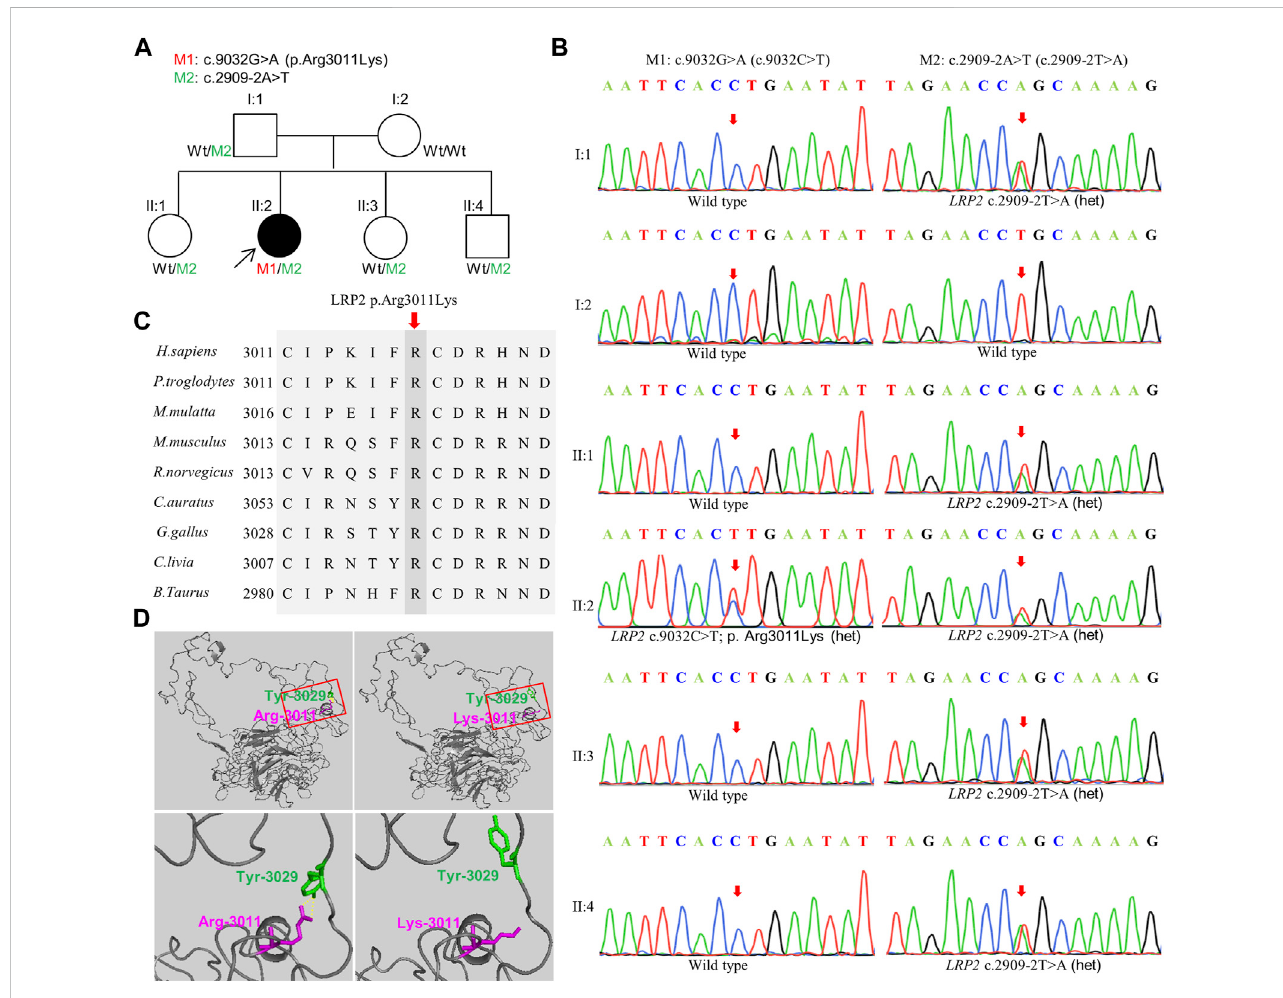
FIGURE 2 Validation of the variation. (A) Pedigree information. Filled black symbol represents the affected member. Two variations are M1: c.9032G > A (p.Arg3011Lys) and M2: c.2909-2A > T, Wt indicates Wild type. Proband is indicated by arrow. (B) Complementary sequence chromatograms of identi fi ed sites for all family members. (C) Orthologous protein sequence alignment of LRP2 from human (H. sapiens), chimpanzees (P. troglodytes), rhesus macaque (M.mulatta), mouse (M. musculus), rats (R. norvegicus), Gold fi sh (C.auratus), Chicken (G. gallus), Rock dove (C.livia), and cows (B. taurus). Conserved residues are shaded. (D) Structural analysis of the wild type and mutant LRP2 protein. Hydrogen bonds between residue 3011 and Tyr3029 were eliminated dueto thesubstitution fromarginineto lysine. Overall structureofhumanLRP2andeffect oftheM1:c.9032G > A(p.Arg3011Lys) (top),Squareswithin solidred lines are cropped for magni fi cation (bottom). The yellow dashed line indicates hydrogen bonds.